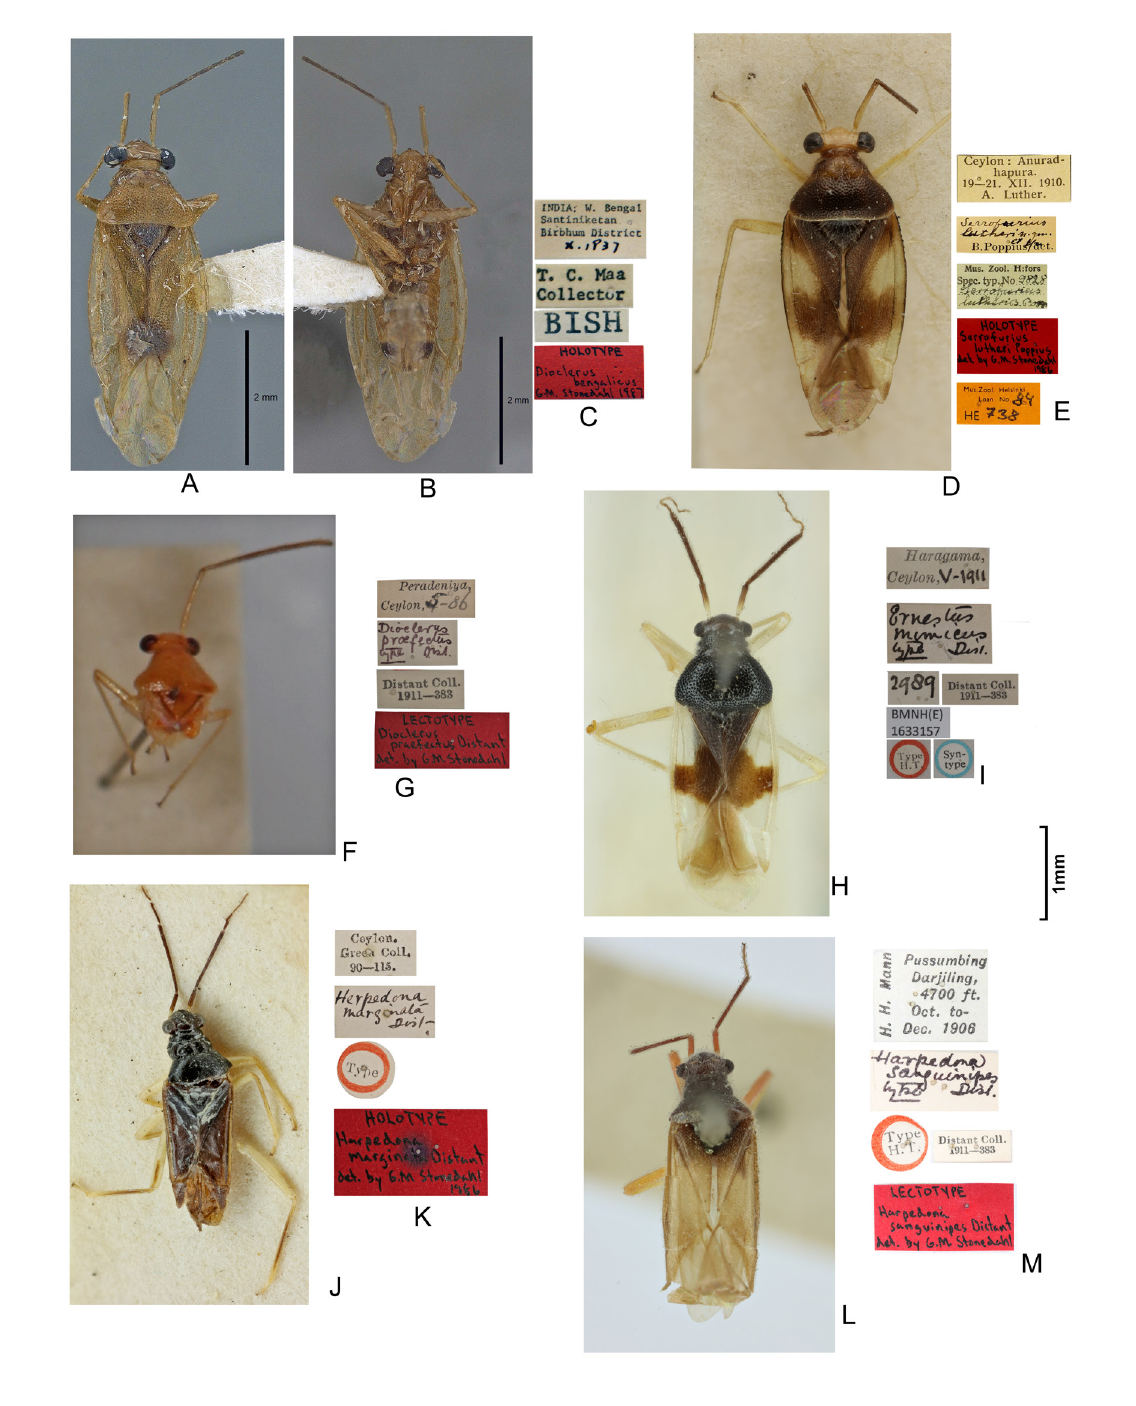
Fig. 5. Dorsal view and label data of type specimens. A–C . Dioclerus bengalicus Stonedahl, 1988, ♀, holotype, BPBM. D–E . Dioclerus lutheri Stonedahl, 1988, ♂, holotype, AMNH_PBI 00338430, FMNH. F–G . Dioclerus praefectus Distant,1910, lectotype, AMNH_PBI 00340384, NHM. H–I . Ernestinus mimicus Distant,1911, ♂, syntype, AMNH_PBI 00085668, BMNH(E) 1633157, NHM. J–K . Harpedona marginata Distant, 1904, ♂, holotype, NHM. L–M . Harpedona sanguinipes Distant, 1909, ♂, lectotype,